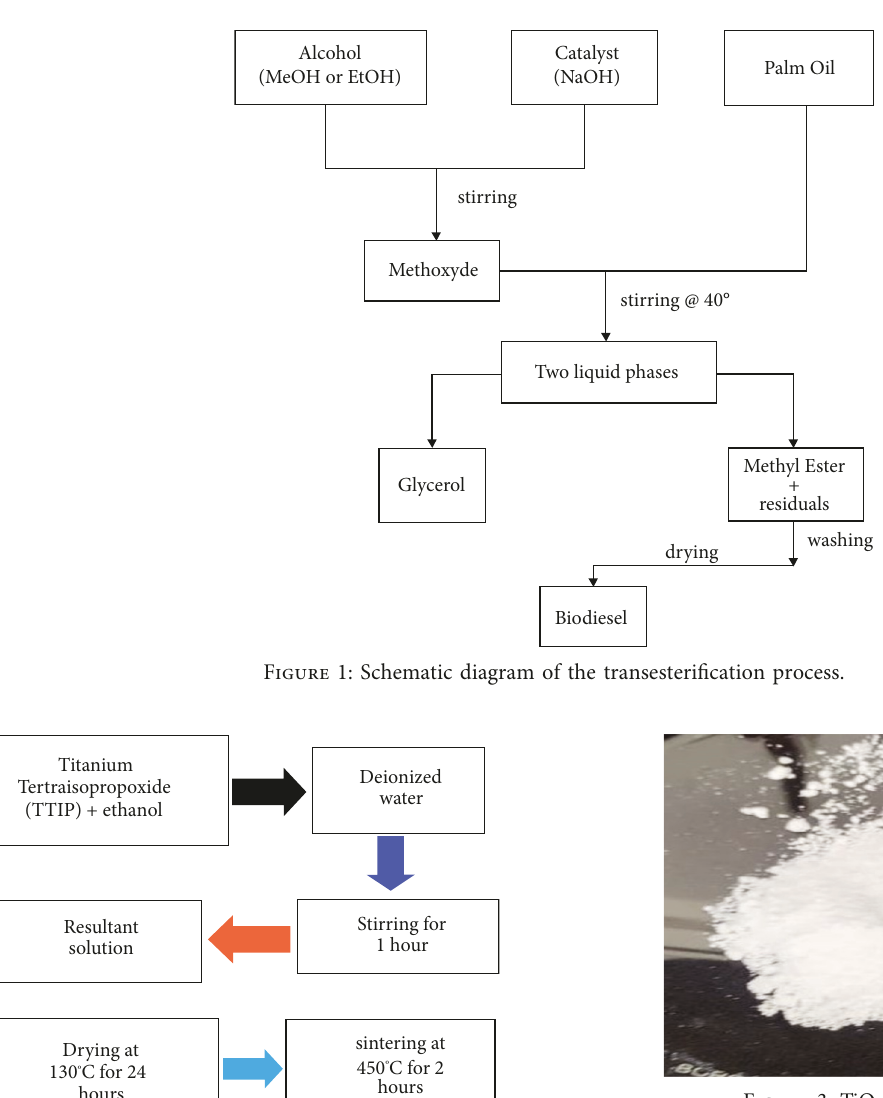
2 nanoparticles.